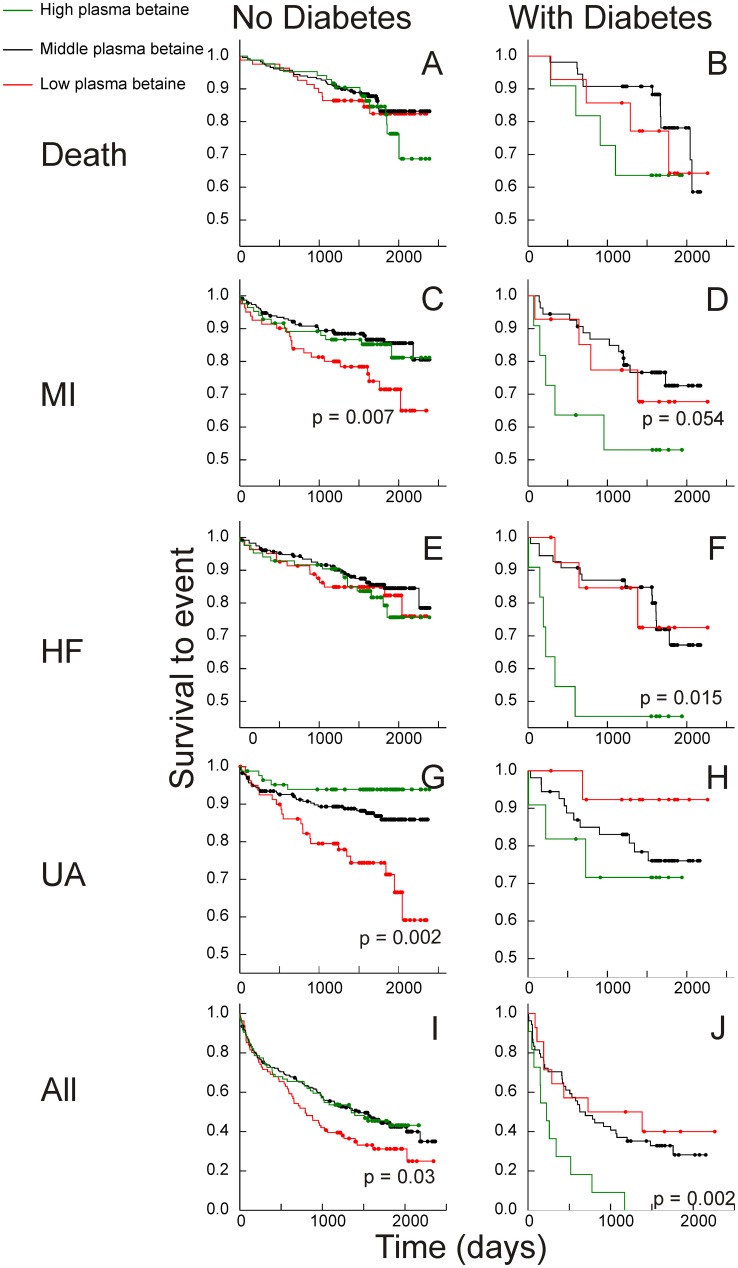
Kaplan-Meier plots: betaine.Plasma betaine concentrations and Kaplan-Meier plots of survival to events. Events: Top (A&B) death from all causes; (C&D) secondary myocardial infarction (MI); (E&F) hospitalization for heart failure (HF); (G&H) unstable angina (UA), and (H&I) all cardiovascular events. On left, A,C,E,G&H are subjects without diabetes; on right, B,D,F,H&J are subjects with diabetes. “High” (green) is the highest quintile of plasma betaine concentration, “Low” (red) the bottom quintile of plasma betaine concentration; “Middle” (black) the remaining 60% of the cohort. All significances are for comparisons with the middle group. Where no significance is shown, p for the difference is >0.3.